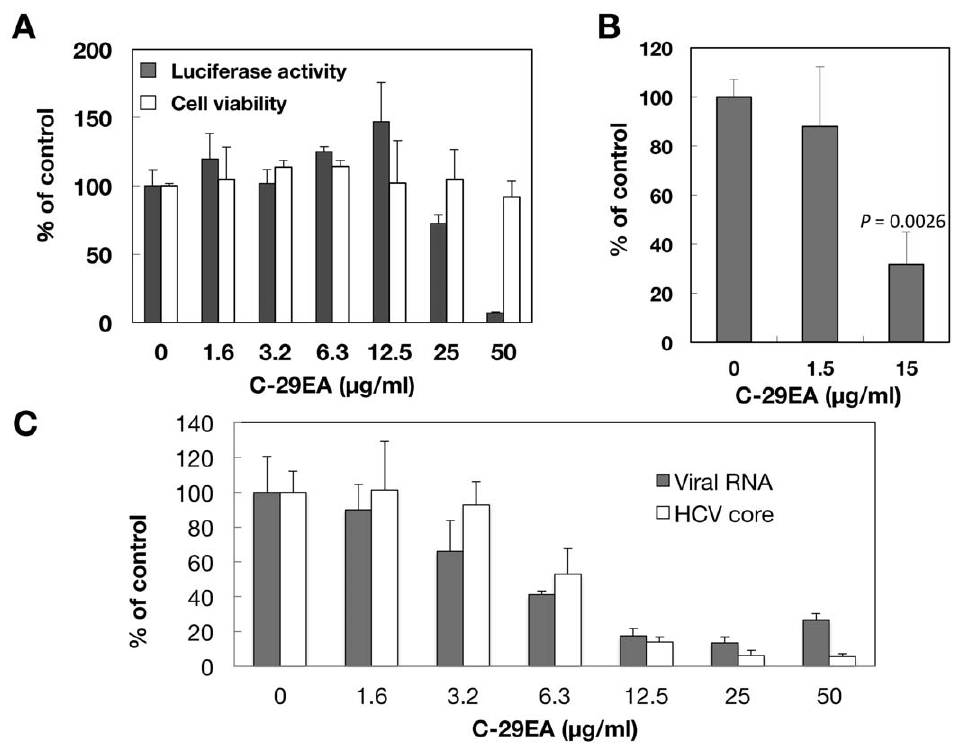
Figure 2. Effect of C-29EA extract on viral replication in the replicon cell line derived from viral genotype 2a. (A) The Huh7 cell line, including the subgenomic replicon RNA of genotype 2a strain JFH1, was incubated in medium containing various concentrations of C-29EA or DMSO (0). Luciferase and cytotoxicity assays were carried out as described in Materials and Methods. (B) The Huh7 OK1 cell line infected with HCVcc JFH1 was incubated with various concentrations of C-29EA or DMSO (0). The virus titers were determined by a focus-forming assay. The significance of differences in the means was determined by Student’s t -test. (C) Amounts of viral RNA and core protein were estimated by qRT-PCR and ELISA, respectively. Error bars indicate standard deviation. The data represent three independent experiments. Treatment with DMSO corresponds to ‘0 9 .